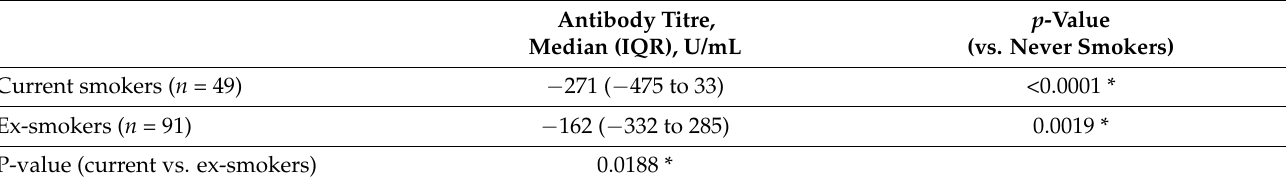
Table 4. Age-adjusted median antibody titres in ever smokers: current smokers vs. ex-smokers. Antibody Titre, Median (IQR),